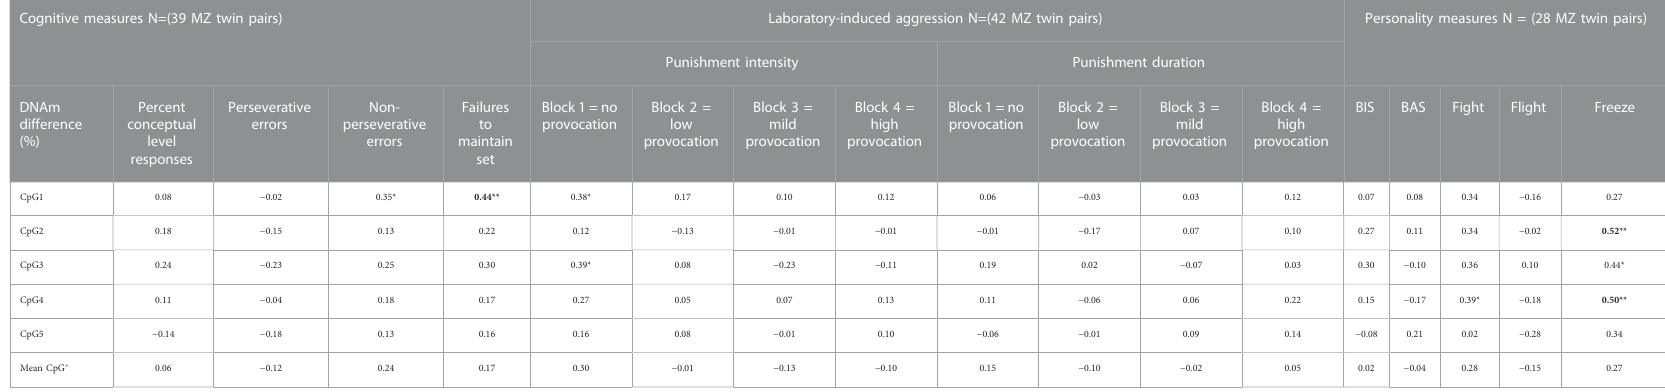
TABLE 4 Spearman ’ s rho coef fi cients between differences in CpGs and psychological measures. Cognitive measures N=(39 MZ twin